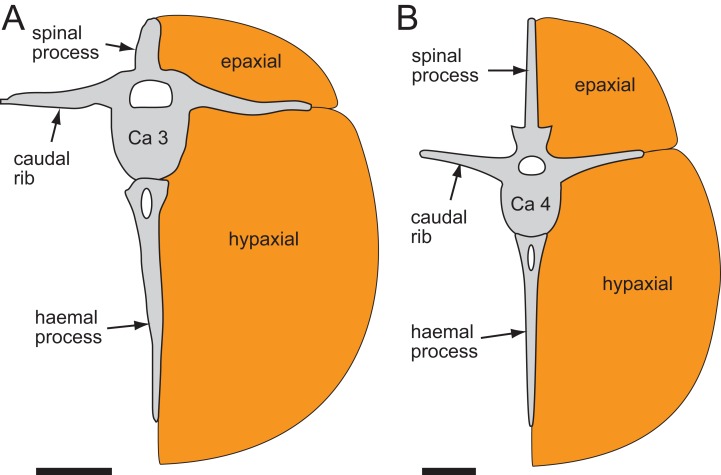
Schematic transverse section through the anterior epaxial and hypaxial muscular regions of the ornithopod tail.(A) Diluvicursor pickeringi gen. et sp. nov. holotype (NMV P221080), designated Ca 3 (see also Fig. 9); and (B) Hypsilophodon foxii, Ca 4 (NHMUK R196; following Galton, 1974, figs. 28–29). Sections normalised for total vertebral depth. Abbreviations: Ca #, caudal vertebra and position. Scale bars equal 10 mm.